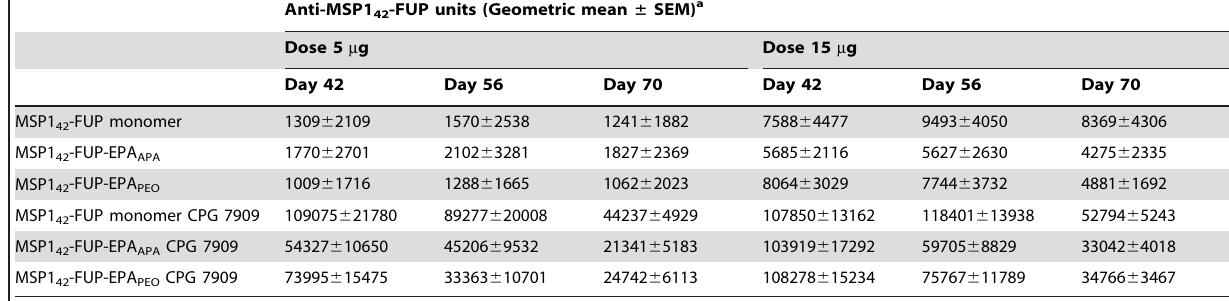
Table 2. Anti-MSP1 42 -FUP antibody titers in